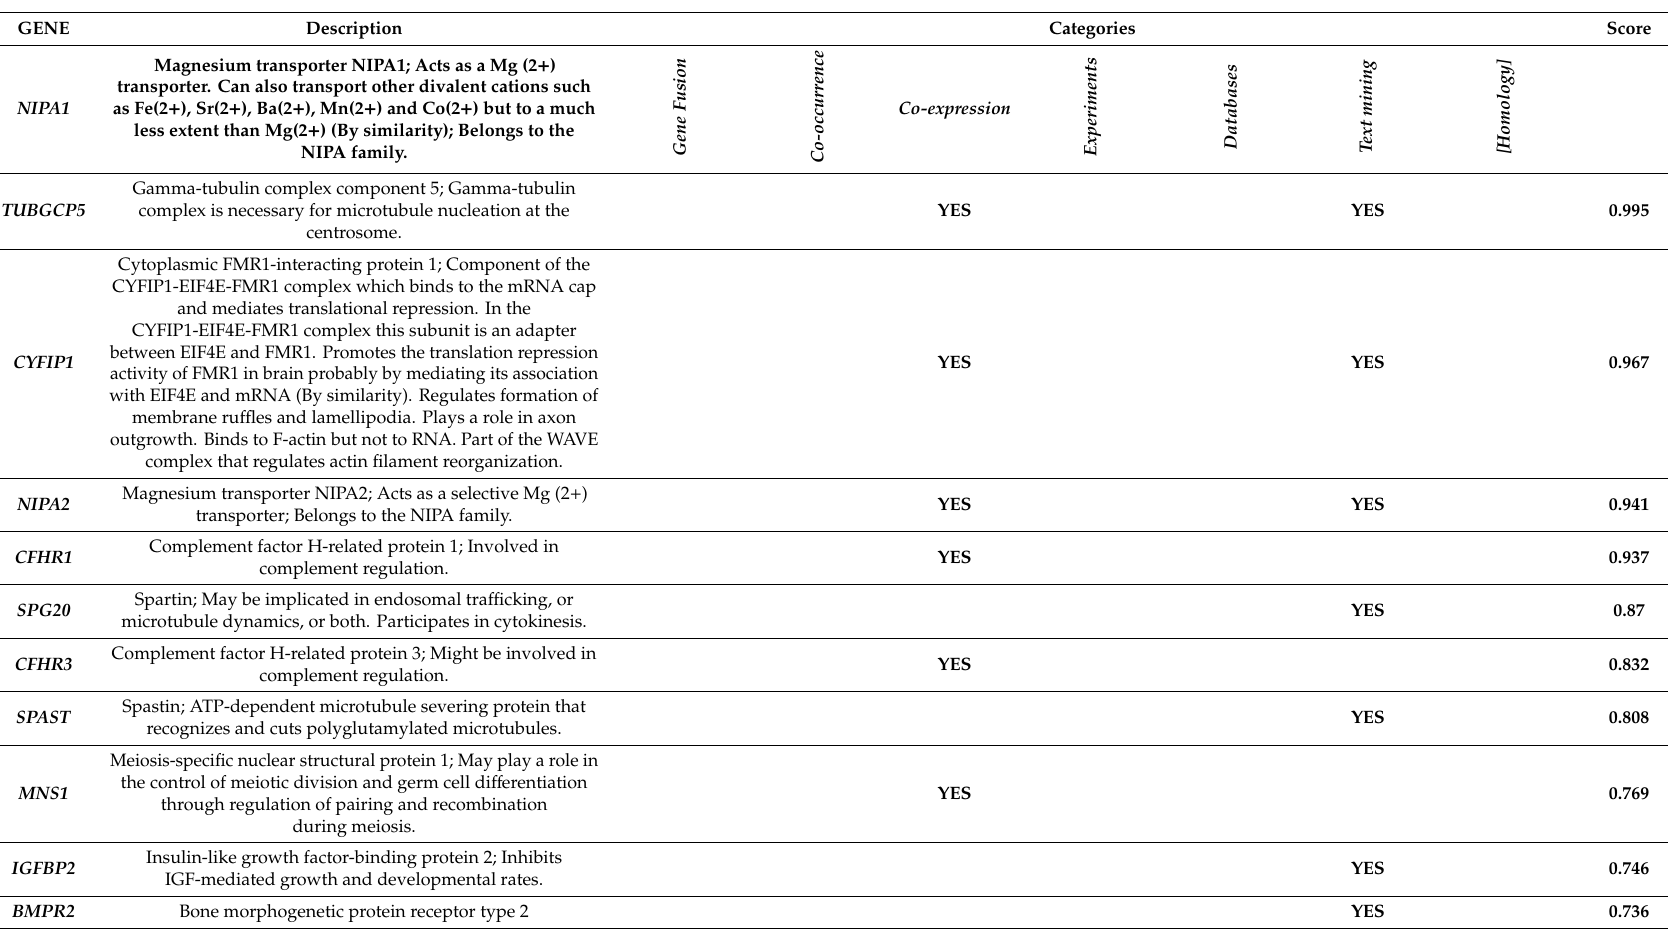
Table 1. STRING: Predicted Functions for NIPA1 , NIPA2 , CYFIP1 , and TUBGCP5